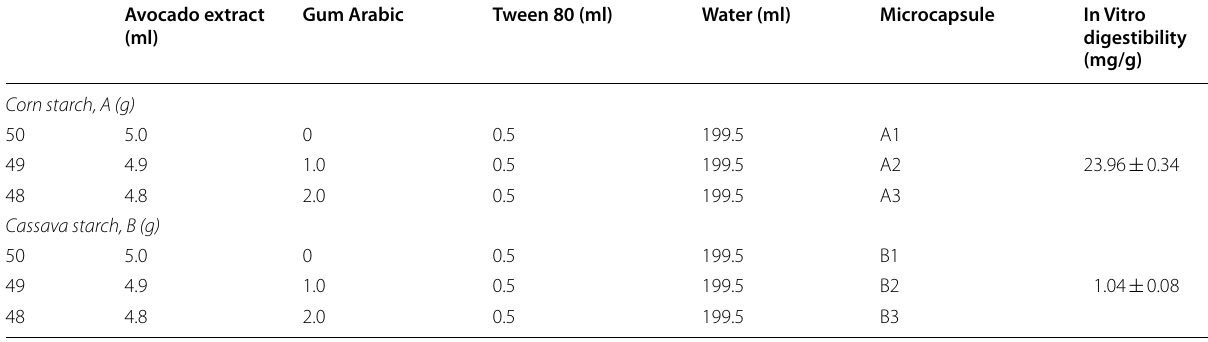
Table 1 Microencapsulation formulation of avocado seed extract and in vitro digestibility of the microcapsule Avocado extract Gum (ml)